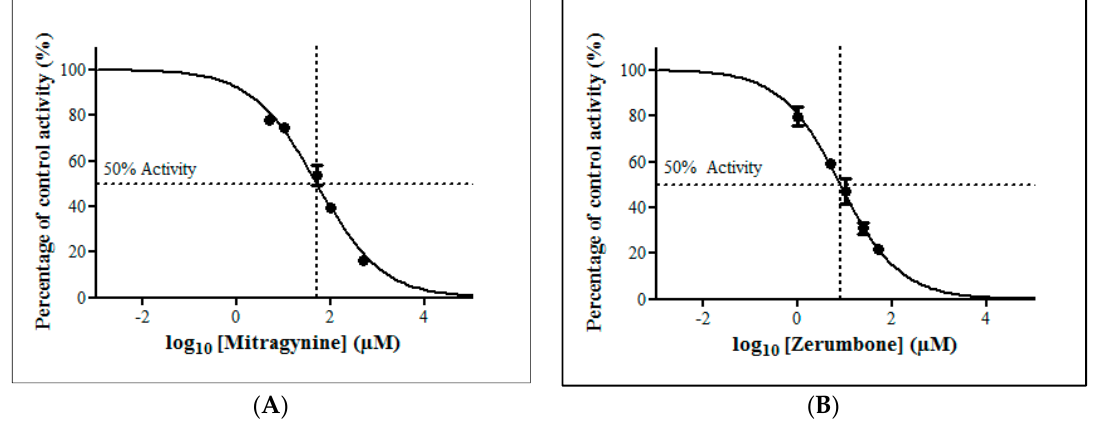
the mean percentage activity relative to control ± standard deviation (SD) for triplicates ( n = 3). Molecules 2018 , 23 , x